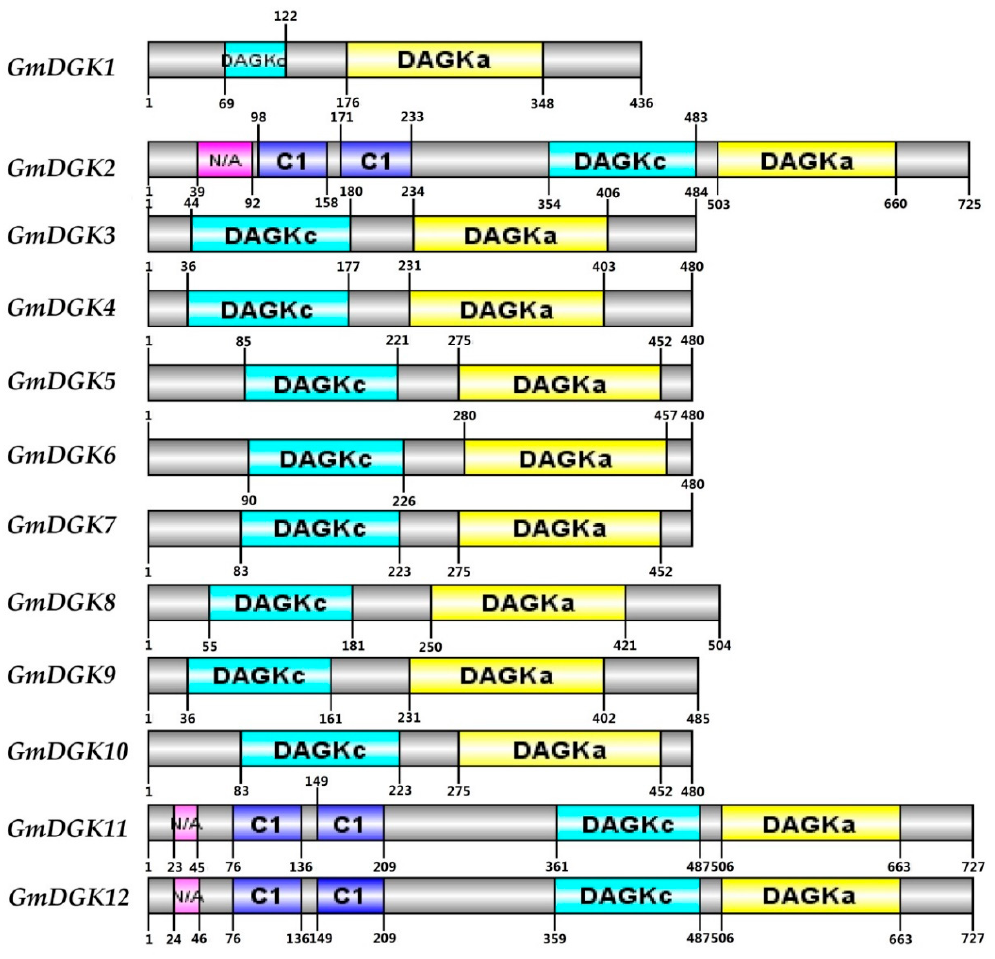
Figure 6. Functional domain analysis of soybean DGK proteins. The numbers show the positions of each amino acid in the protein.